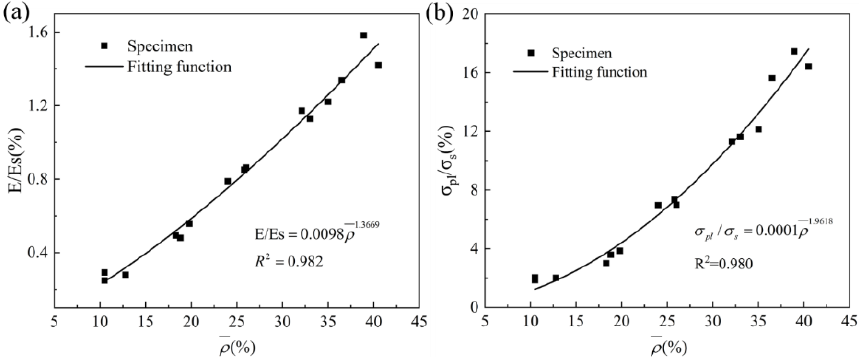
Figure 11. The relative mechanical properties with respect to the relative density: ( a ) Young’s modulus; ( b ) plateau stress.